Question: What kind of plot is shown here?
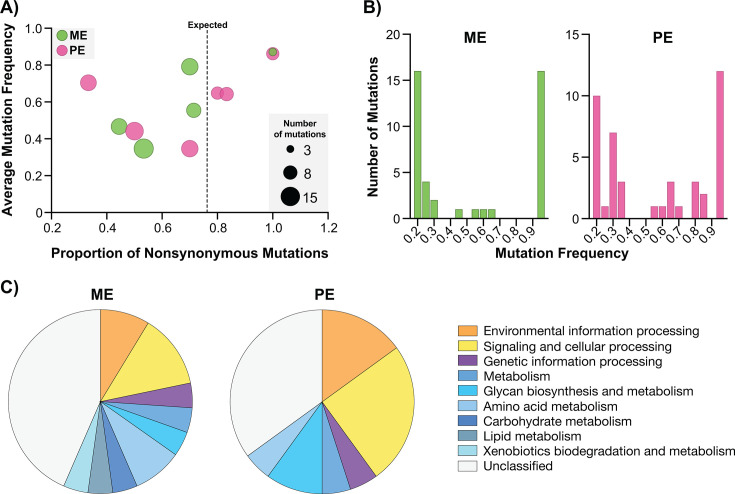
Answer: scatter